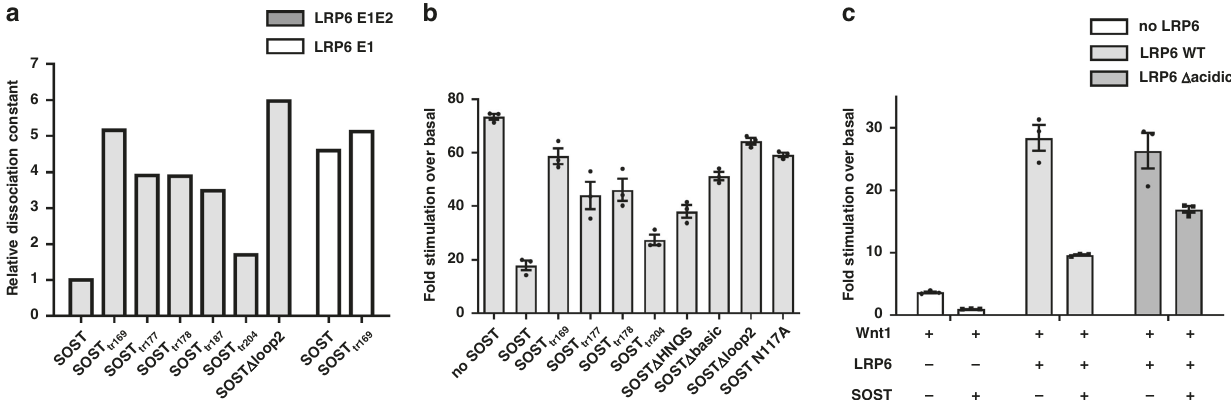
Fig. 4 Effects of the SOST C-tail on LRP6 binding and Wnt1-signaling inhibition. a The af fi nities of various SOST mutants for LRP6 E1E2 or LRP6 E1 were measured by MST, and the relative K D values from those measurements are shown. The K D value of SOST WT for LRP6 E1E2 was used as a reference. The experimentally determined K D values are provided in Supplementary Table 2. b The inhibitory effects of SOST mutants on Wnt1 signaling were detected by TopFlash assays. Each luciferase signal observed after co-transfecting plasmids encoding Wnt1 and each SOST mutant was normalized to that found with the empty-vector control. c Differences in the inhibitory activities of SOST with WT LRP6 or the LRP6 Δ acidic mutant in LRP6-knockout HEK293T cells are shown in the bar graph. Data from three independent experiments ( n = 3) were analyzed and expressed as mean ± SEM in b and c a SOST Δ basic mutant, in which all basic residues in the C-